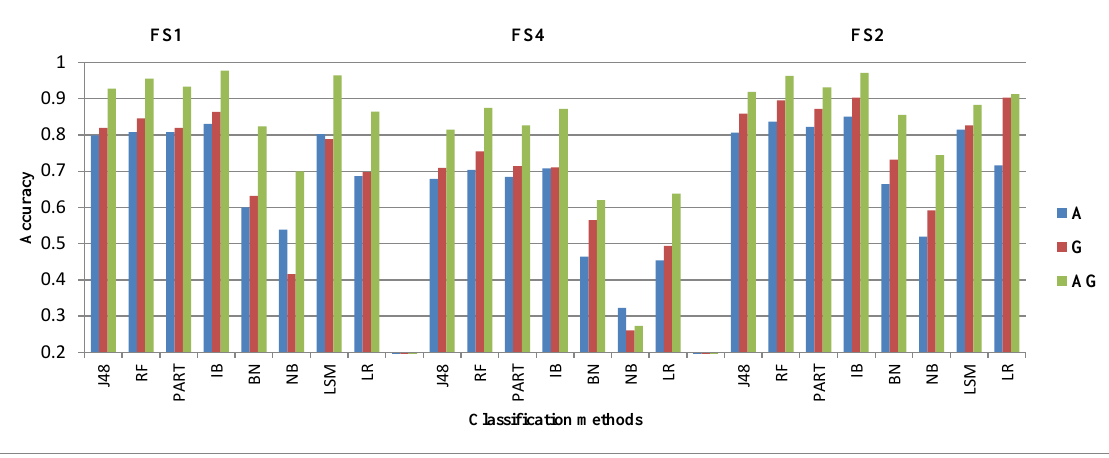
Figure 4. The recognition performance for the walking downstairs activity in Scenario B.